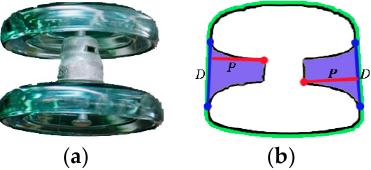
Figure 4. Convex hull and convexity defect of two adjacent glass insulator sheds. ( a ) the original image, ( b ) the processed image.